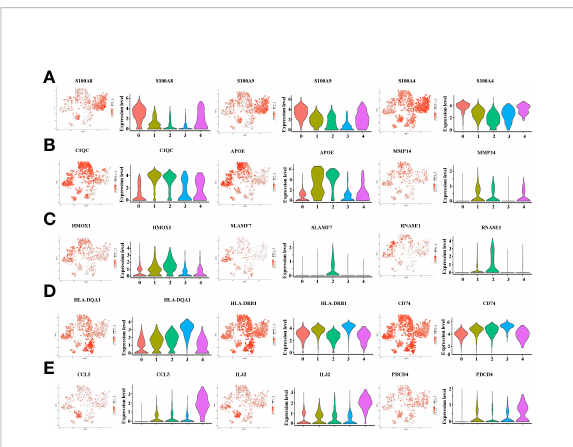
FIGURE 5 (A) tSNE plots, color-coded (gray to red) for the expression of marker genes for macrophage subpopulation 0, as indicated (left); Violin plots of marker genes for macrophage subpopulation 0, as indicated (right). (B) tSNE plots, color-coded (gray to red) for the expression of marker genes for macrophage subpopulation 1, as indicated (left); Violin plots of marker genes for macrophage subpopulation 1, as indicated (right). (C) tSNE plots, color-coded (gray to red) for the expression of marker genes for macrophage subpopulation 2, as indicated (left); Violin plots of marker genes for macrophage subpopulation 2, as indicated (right). (D) tSNE plots, color-coded (gray to red) for the expression of marker genes for macrophage subpopulation 3, as indicated (left); Violin plots of marker genes for macrophage subpopulation 3, as indicated (right). (E) tSNE plots, color-coded (gray to red) for the expression of marker genes for macrophage subpopulation 4, as indicated (left); Violin plots of marker genes for macrophage subpopulation 4, as indicated analyzed the GO terms to compare the signi fi cant differences